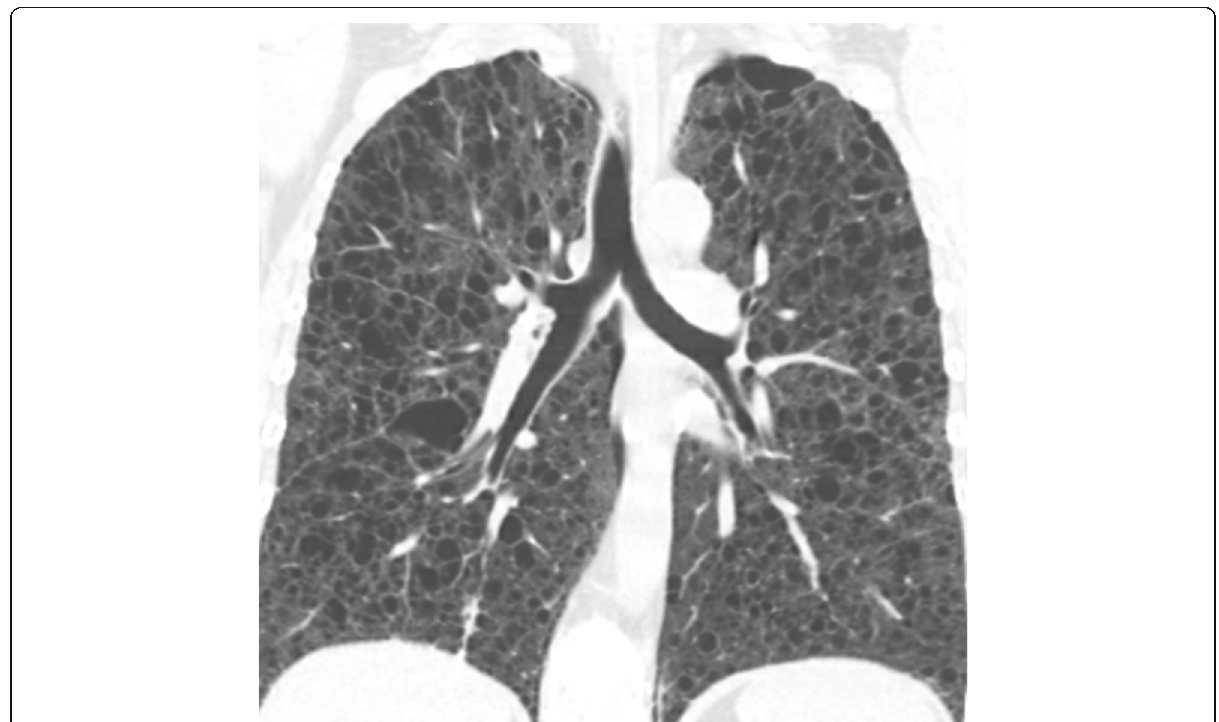
Fig. 1 Coronal CT reformatted image of the chest shows diffuse severe pulmonary involvement by thin-walled cysts. Although several cysts are small (2 – 5 mm), the majority are much larger, measuring up to 12 mm. Note variable cyst shapes including polygonal shapes and a diffuse involvement of the